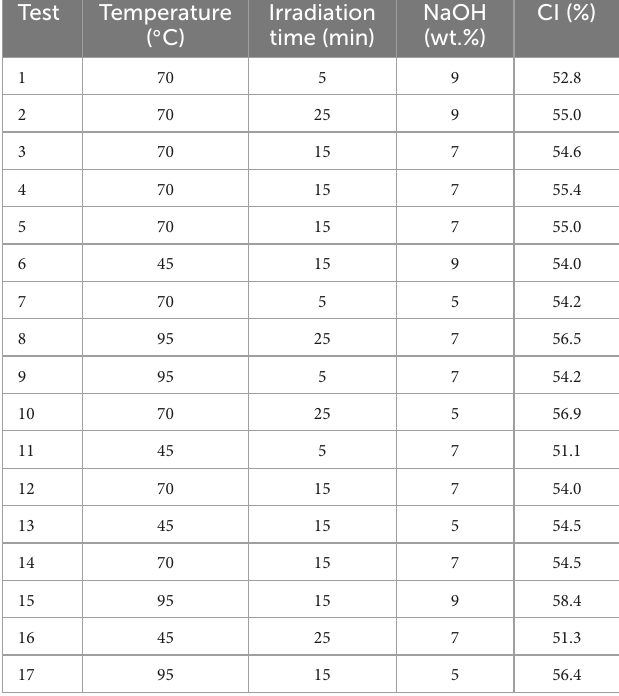
TABLE 1 Chemical reaction conditions used for obtaining CNCs from AS by following the conventional procedure. Treatment Chemical reaction Time Sample